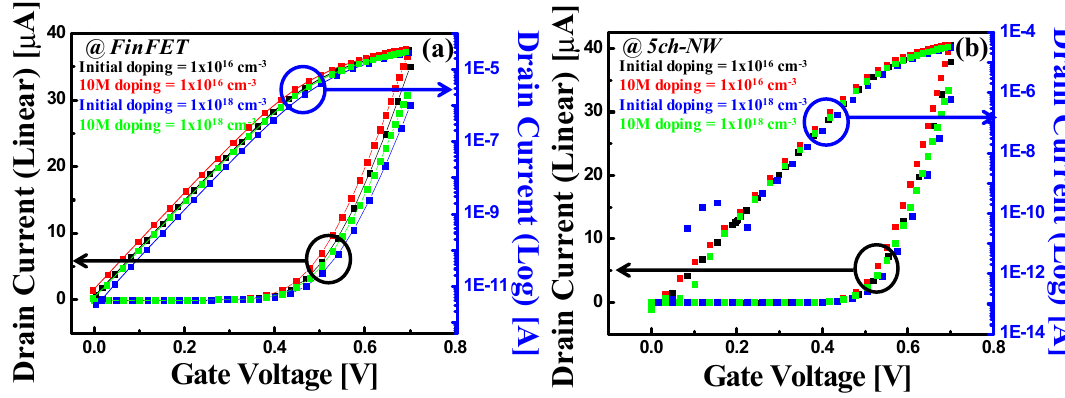
Figure 8. The simulation results according to channel doping. ( a ) FinFET, ( b ) 5ch-NW.